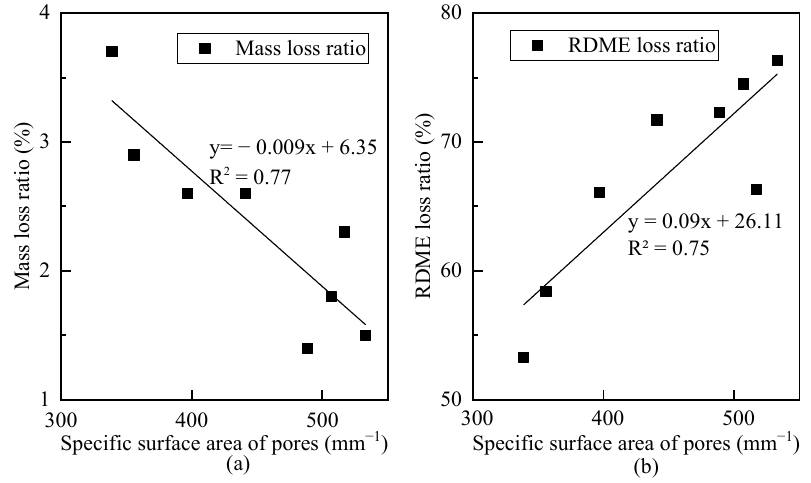
Figure 8. Correlations between pore specific surface area and loss ratio ( a ) mass, ( b ) RDME.